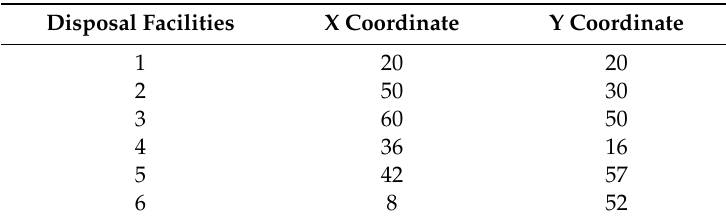
Table 7. Positions of all disposal facilities.